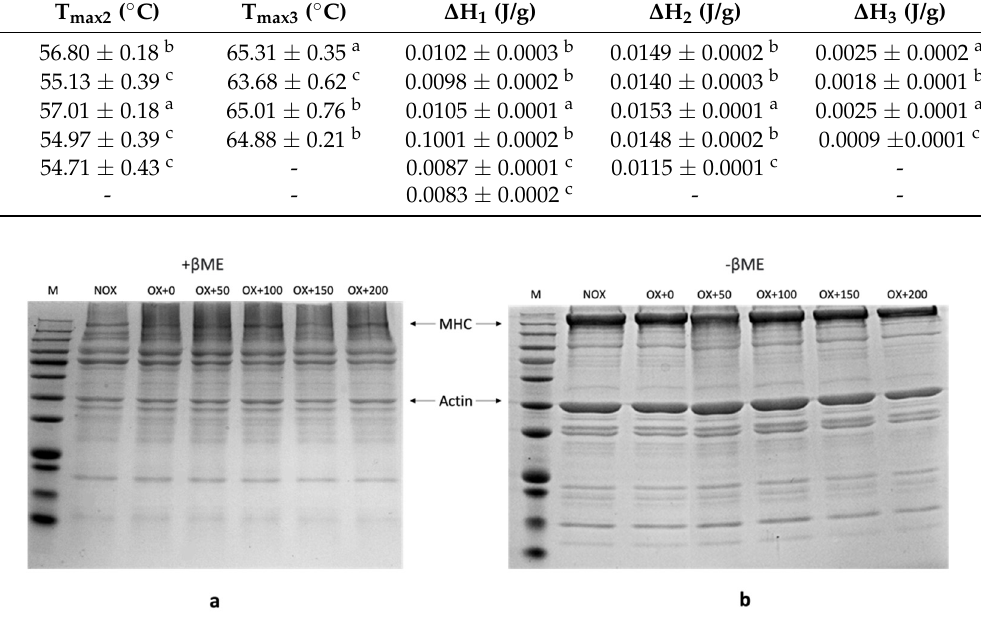
Figure 2. SDS-PAGE patterns of MPs oxidatively stressed in the absence of FOs at different concen- trations (0, 50, 100, 150, and 200 µ mol/g protein). Samples were prepared in the presence (( a ), + β Me) or absence of β -mercaptoethanol (( b ), − β Me). M, marker; NOX, nonoxidized; OX, oxidized; OX + 0, OX + 50, OX + 100, OX + 150, and OX + 200: oxidized in the presence of FOs at 0, 50, 100, 150, and 200 µ mol/g protein, respectively.